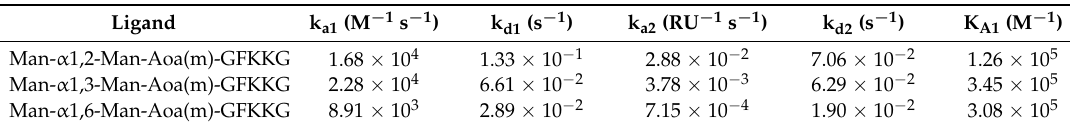
Figure 1. Binding of Con A to immobilized mannobiose-containing glycoprobes (( a ) Man- α 1,2-Man; ( b ) Man- α 1,3-Man; ( c ) Man- α 1,6-Man) at six different concentrations (2.5, 5, 10, 20, 40 and 80 nM). Fitting curves using a bivalent model are shown as dotted black lines. Table 2. Kinetic constants of the interaction of Con A with mannobiose-containing glycoprobes determined by